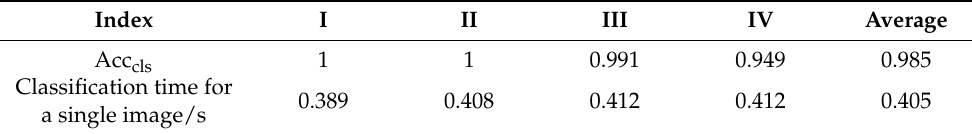
Table 3. Test results of secondary classification.